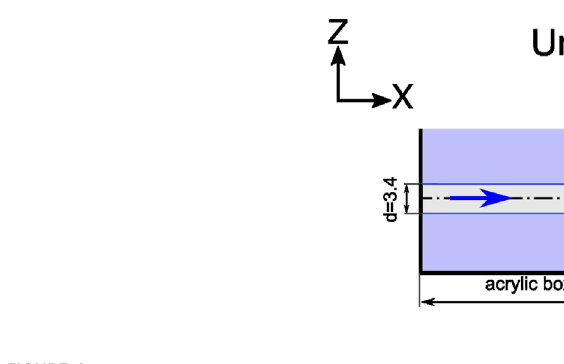
FIGURE 4 A schematic of the phantom in the study.